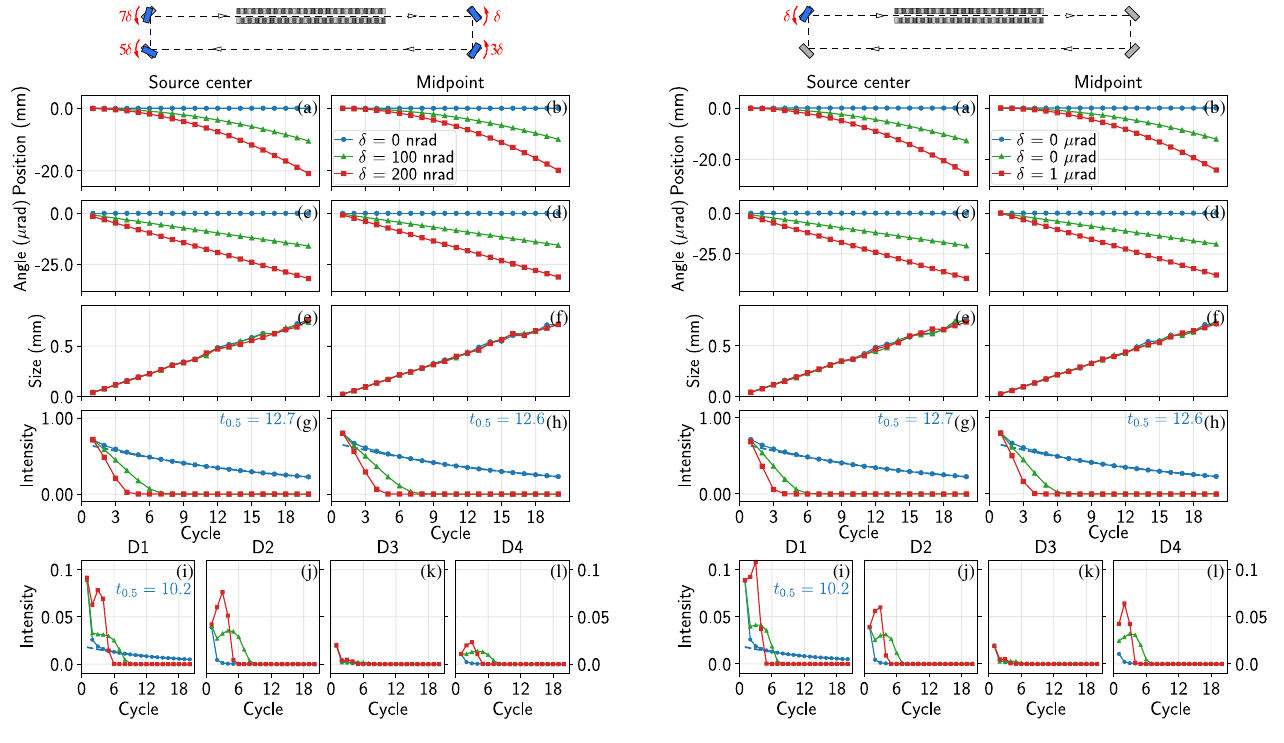
FIG. 9. Simulation results of the beam dynamics in the rectangular four-crystal cavity without lenses with systematically misaligned crystal yaw angles.